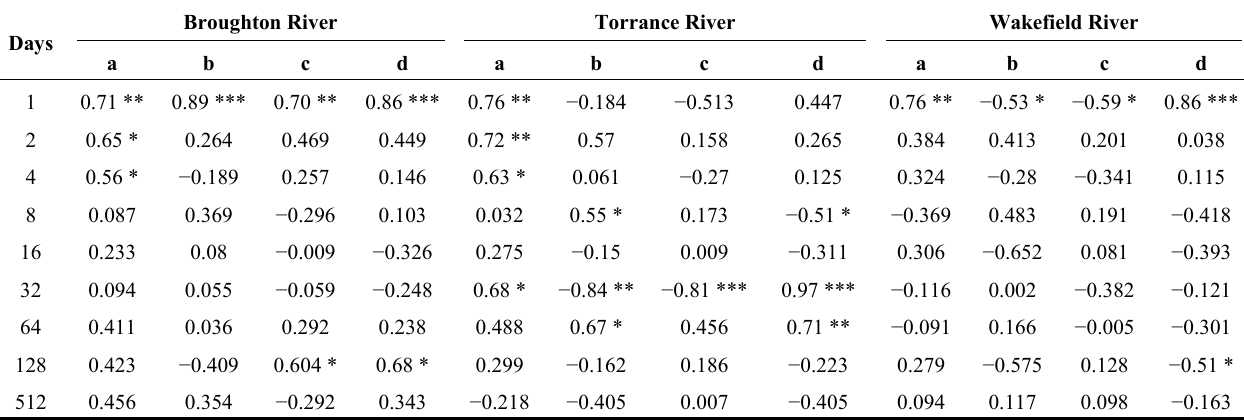
Table 3. Constructed correlation pattern for different levels between (a) adjusted rainfall and adjusted stream flow; (b) squared adjusted rainfall and adjusted stream flow; (c) adjusted rainfall and squared adjusted stream flow; (d) squared adjusted rainfall and squared adjusted stream